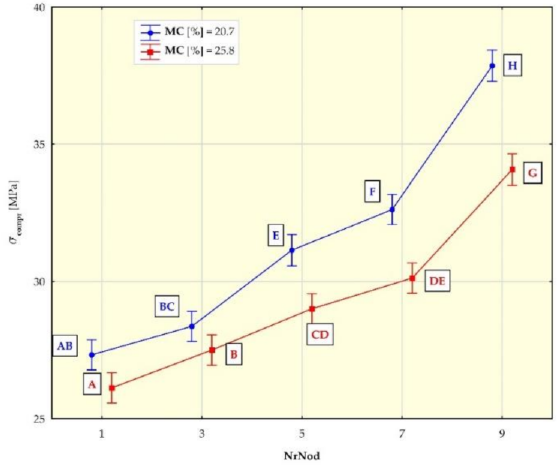
Figure 7. Average modulus of elasticity in compression (MOE comp ) values for different internodes (NrNod) and moisture content (MC). All data are expressed as mean ± 95% confidence interval (the latter being represented by whiskers in the diagram). Different letters indicate significant differences between the groups according to Tukey’s test ( p < 0.05). Homogeneous groups are marked with the same letters.